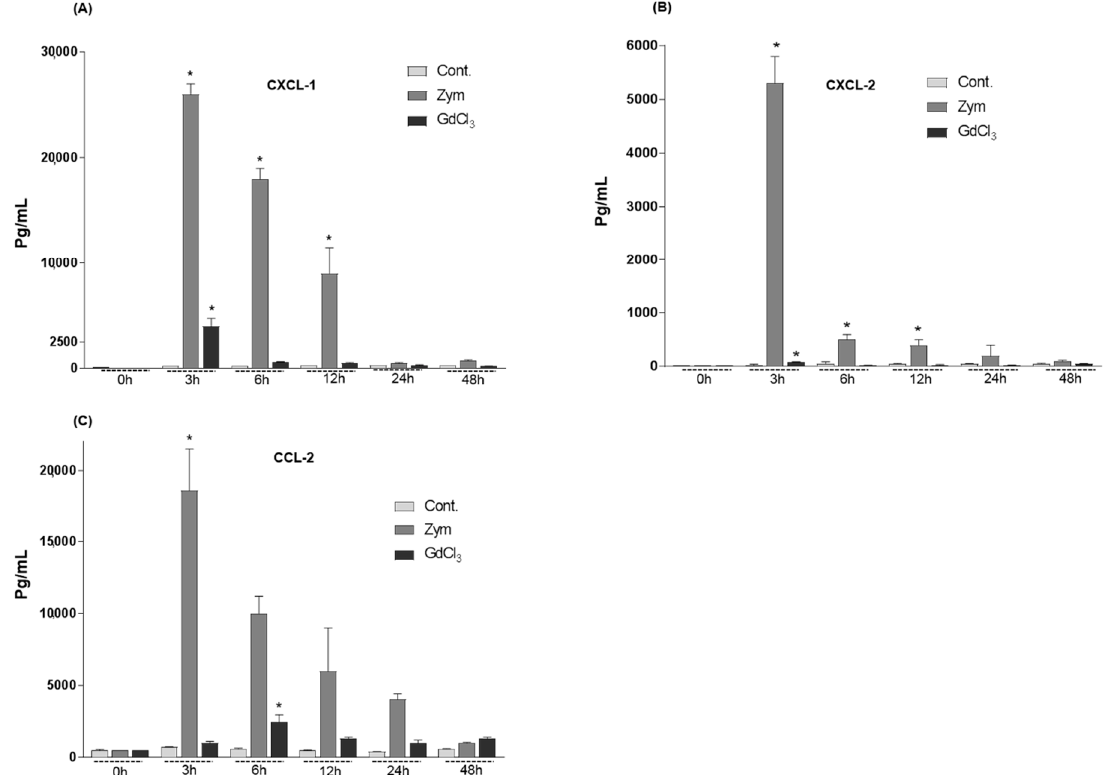
Figure 4. Changes in the serum levels of CXCL-1, CXCL-2 and CCL-2 in intraperitoneally administrated GdCl 3 or Zymosan rats by enzyme-linked immunosorbent assay (ELISA) measurement. ( A ) CXCL-1 levels in the serum of intraperitoneally administrated GdCl 3 or Zymosan rats. Zymosan treated rats shows pronounced CXCL-1 serum levels at 3 h than GdCl 3 treated rats. ( B ) CXCL-2 levels in the serum of GdCl 3 and Zymosan treated rats. Zymosan treated rats shows pronounced CXCL-2 serum levels at 3 h than GdCl 3 treated rats. ( C ) CCL-2 levels in the serum of GdCl 3 and Zymosan treated rats. Zymosan treated rats shows pronounced CCL-2 serum levels at 3 h, while in GdCl 3 treated rats increased slightly at 6 h. Values on the y-axis show the serum concentration of CXCL-1, CXCL-2 and CCL2 measured with ELISA. These results are representative of six animal series (* p < 0.05; mean ± standard error of the mean (SEM)).